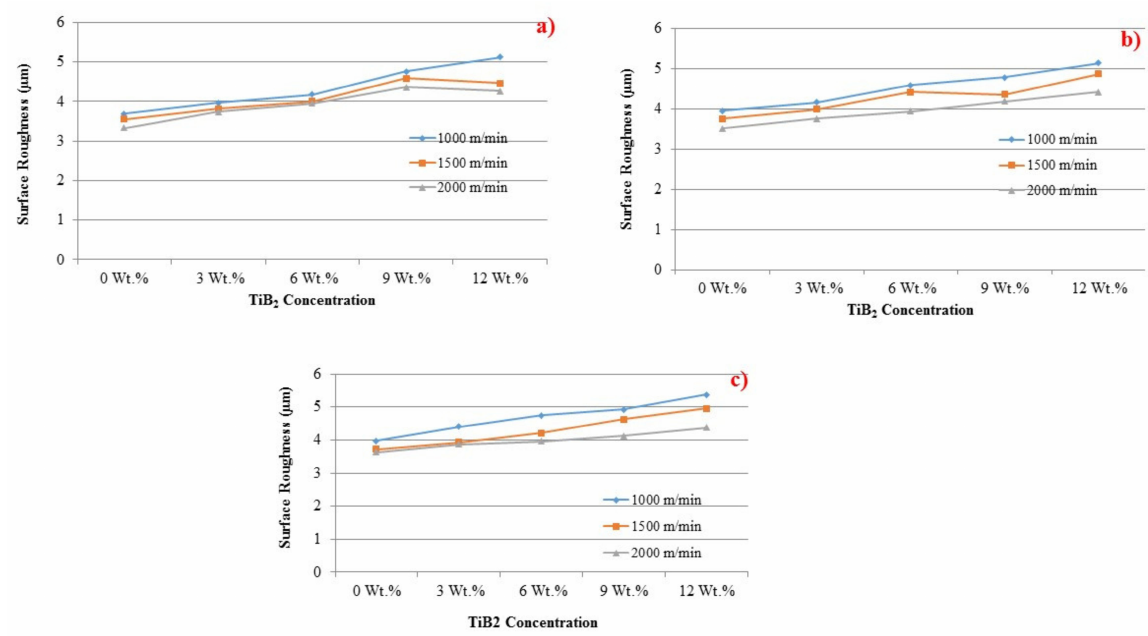
Figure 9. Influence of TiB 2 particles on surface roughness at the feed rate levels of ( a ) 0. 5 mm/rev, ( b ) 1.0 mm/rev and ( c ) 1.5